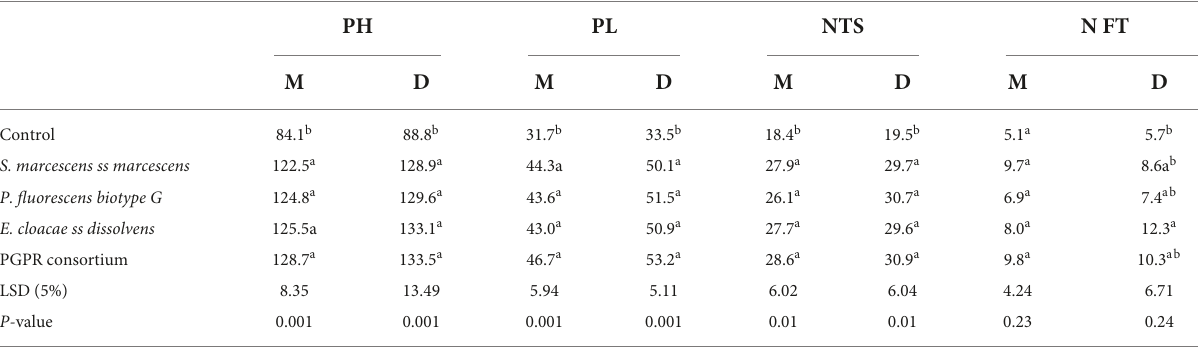
TABLE 3 PGPR inoculation effects on teff varieties growth and growth-related traits.